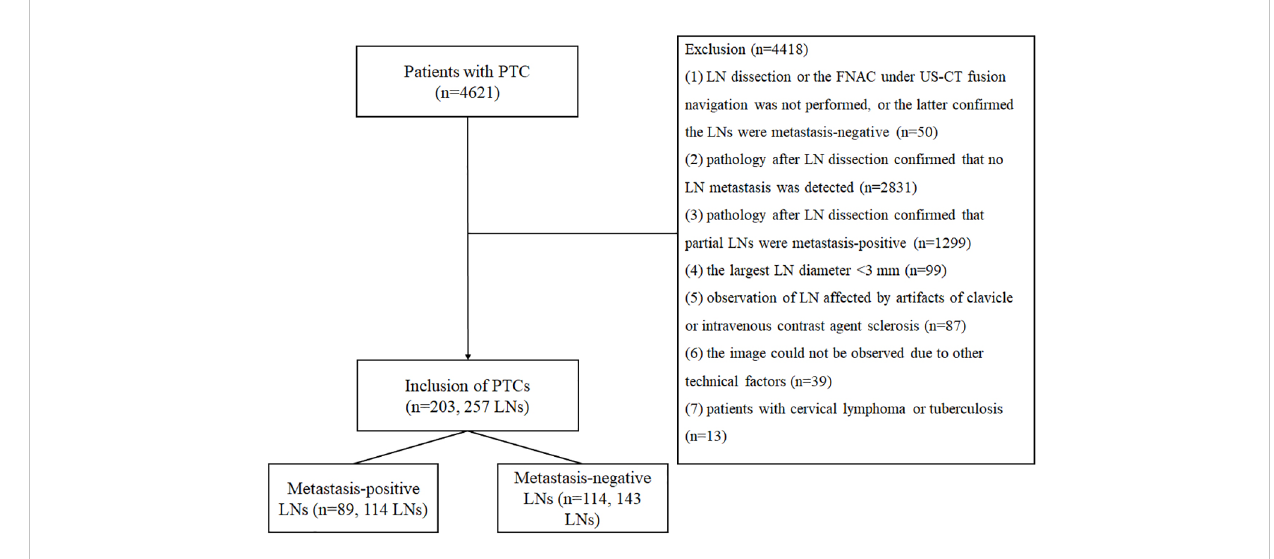
FIGURE 1 Flow chart of the study